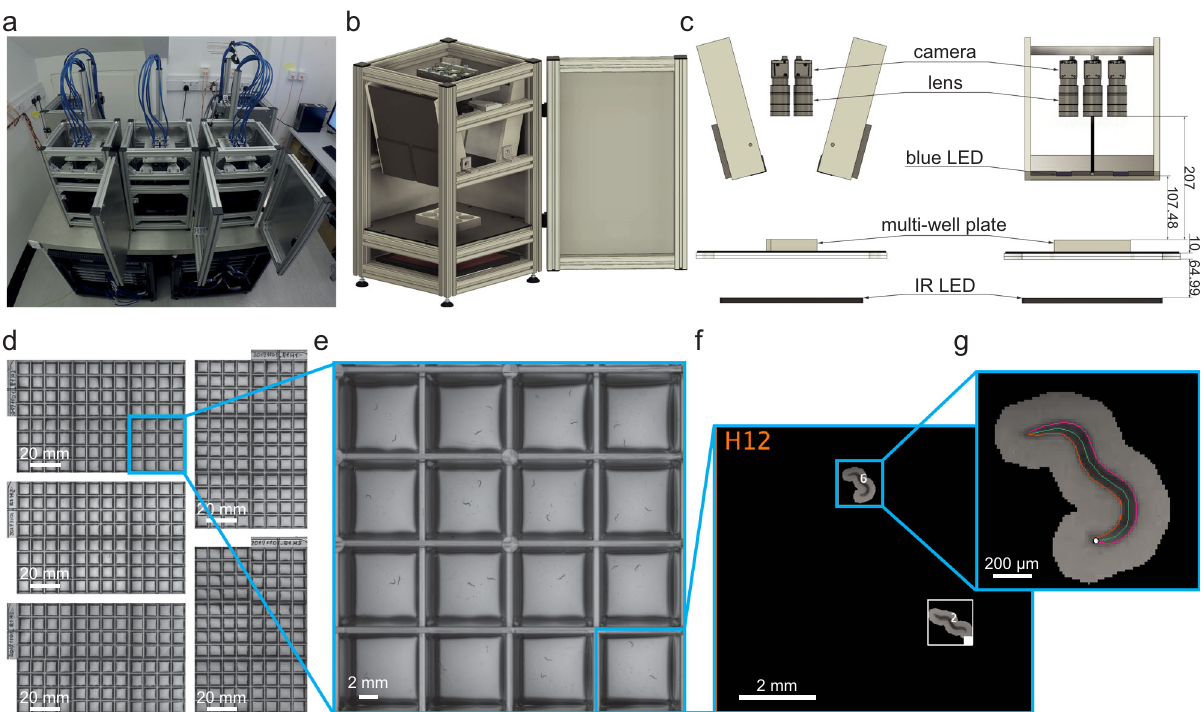
Fig. 1 Schematic of megapixel camera arrays. a Five identical camera arrays were mounted on an air supported table. The associated workstations to run the Motif software were arranged in the two server racks underneath. b 3D schematic drawing of a single imaging unit (Kastl – Highres). The six cameras were mounted on a plate that is connected to the rig frame by three spring-loaded screws, and can be moved along the vertical axis. This allows for changing the focal plane of all six cameras at once. One of the imaging unit ’ s side panels is omitted from this view. c Technical drawing (front and side view) of an imaging unit annotated with dimensions in millimetres. d Using fi ve identical units, 480 wells can be recorded simultaneously. Zooming in to the ( e ) camera, ( f ) well, ( g ) and worm level shows that this system achieves enough resolution to precisely track the nematodes. Each square well measures 8 × 8